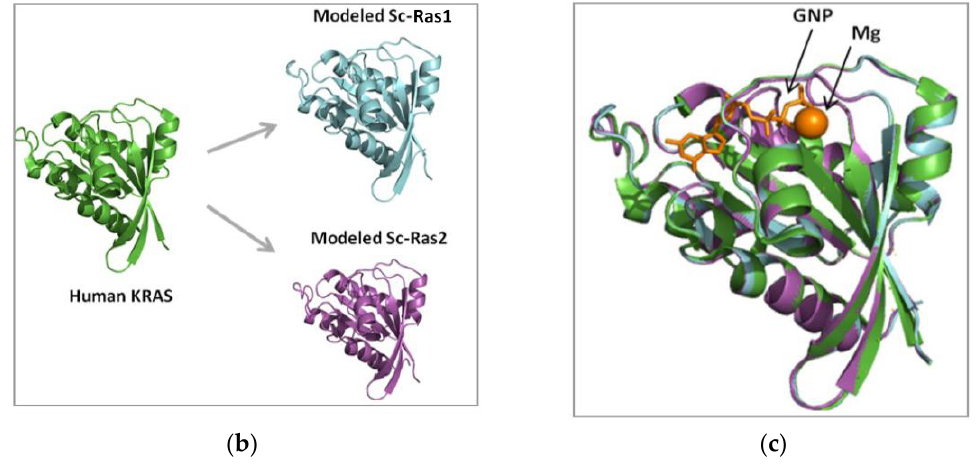
Figure 3. Comparison of RAS proteins between human (Hs) and yeast (Sc) species. ( a ) Alignment of human KRAS, NRAS and HRAS with yeast Ras1 and Ras2. Identical residues at homologous positions are shown in blue. The Gly12 and Gly13 sites are highlighted in red. The CAAX box is highlighted in green. The lysine repeats of KRAS4A are highlighted in pink. Human sequences were obtained from Ensembl (KRAS4B: ENSP00000308495, KRAS4A: ENSP00000256078, NRAS: ENSP00000358548 and HRAS: ENSP00000309845) and yeast sequences from the Saccharomyces Genome Database (RAS1: YOR101W and RAS2: YNL098C). Sequences were aligned in Geneious 5.5.8 [94], using Muscle [95]. ( b ) Models of S. cerevisiae Ras1 (blue) and Ras2 (purple) using human KRAS structure (3GFT) as a template (green). ( c ) The three structures are shown superimposed, revealing the fold similarity. GDP and Mg sites are shown in orange.